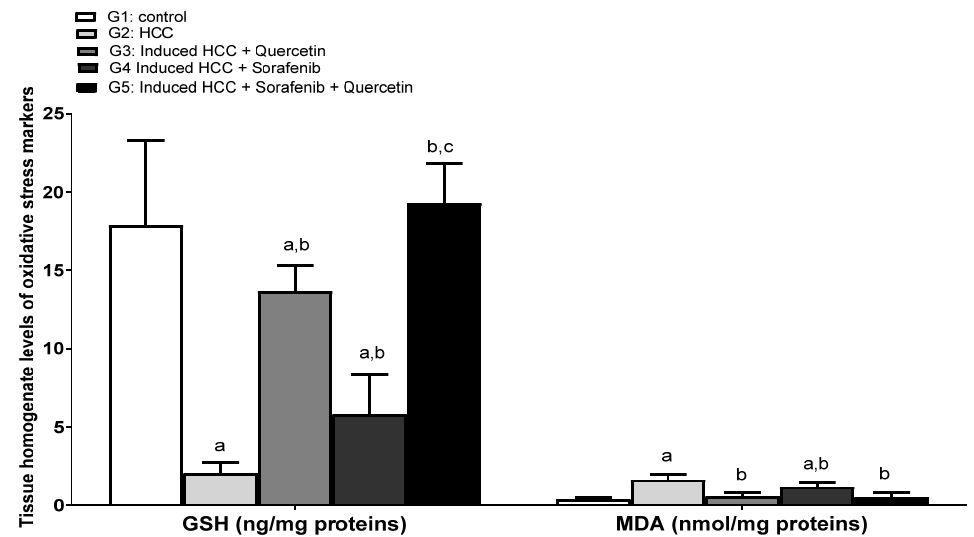
Figure 5. Tissue homogenate levels of oxidative stress markers in different studied groups. Data were expressed as mean +/ − standard deviation. Significance was made using one-way ANOVA test followed by least significant test. a: significance versus group 1. b: significance versus group 2. c: significance versus group 4. GSH: glutathione; MDA: malondialdehyde. Significance at p < 0.050.